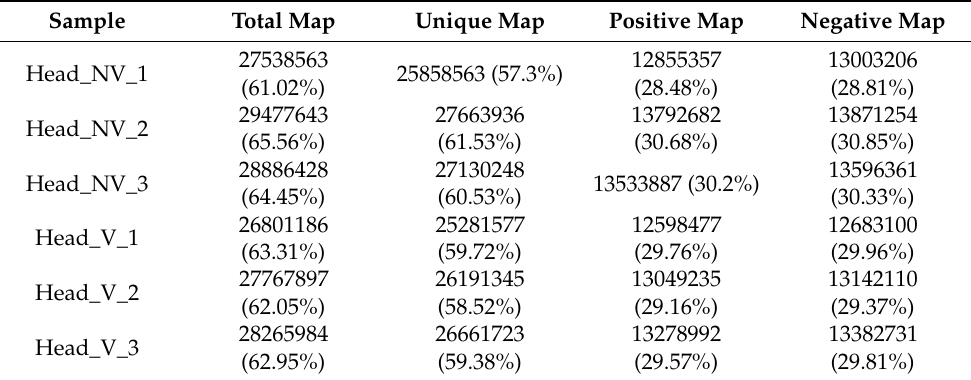
Table 2. Summary statistics of transcriptome sequencing data mapping to the reference